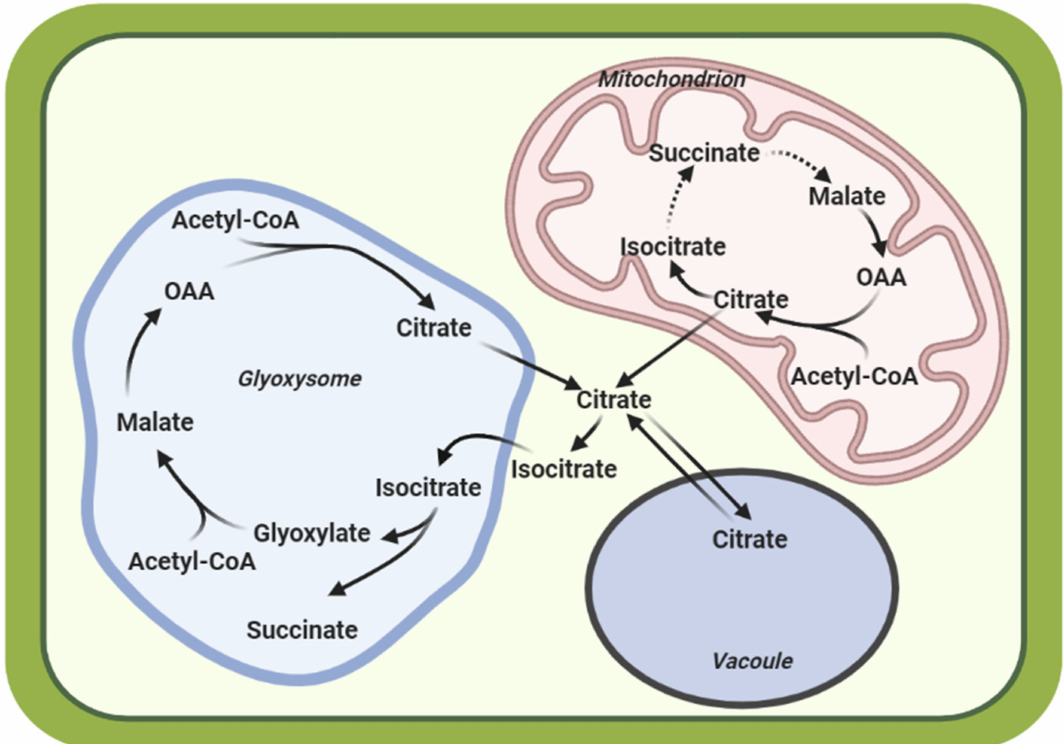
Figure 1. A simplified model showing the biosynthetic pathway of CA in plant cells. CA biosynthesis occurs in the TCA cycle in the mitochondria or via the Glyoxylate cycle in the glyoxysome. CA is exported to the cytosol where it can remain or be stored in the vacuole. Citric acid/Citrate, CA; oxaloacetate,